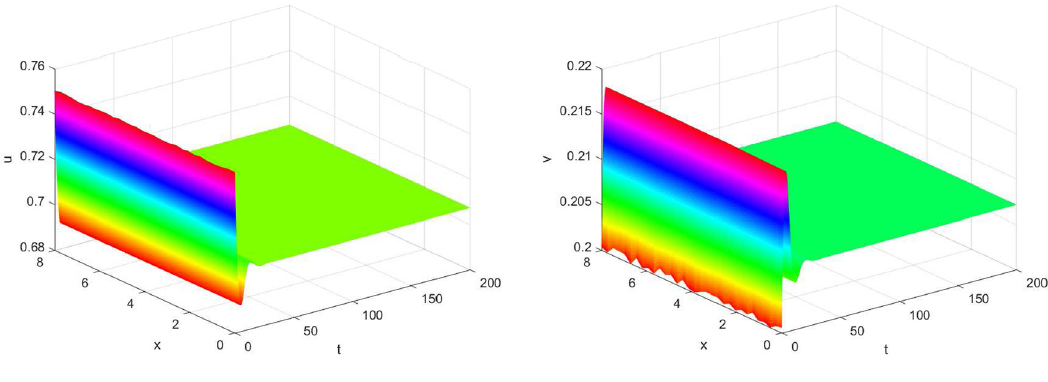
Figure 4: Phase portraits of ( 1.5 ) with parameters =